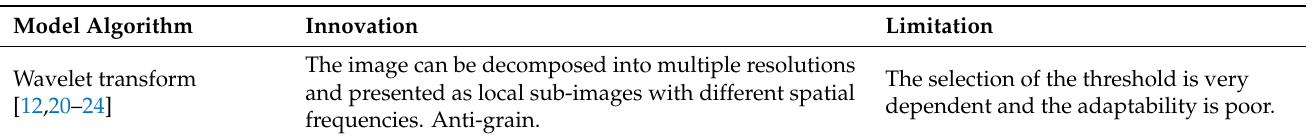
Table 1. Comparison of image processing